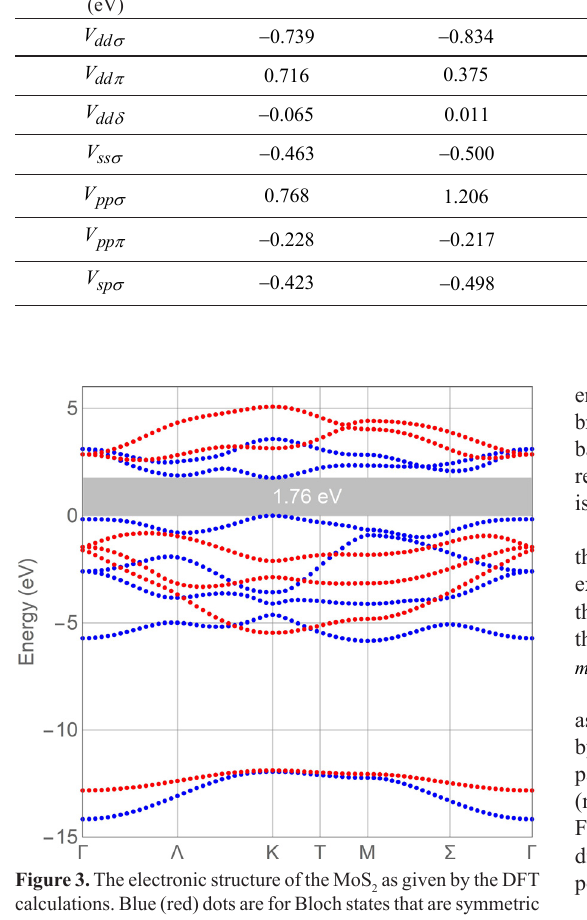
Table 2. As of Table 1 , but for the optimized hopping integrals. Hopping integral